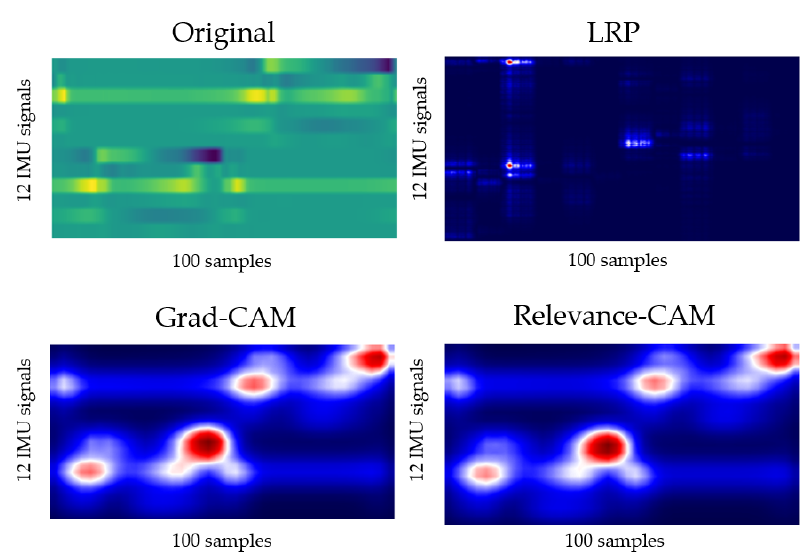
Figure 7. Layer2 result of applying LRP, Grad-CAM, and Relevance-CAM to ResNet50.